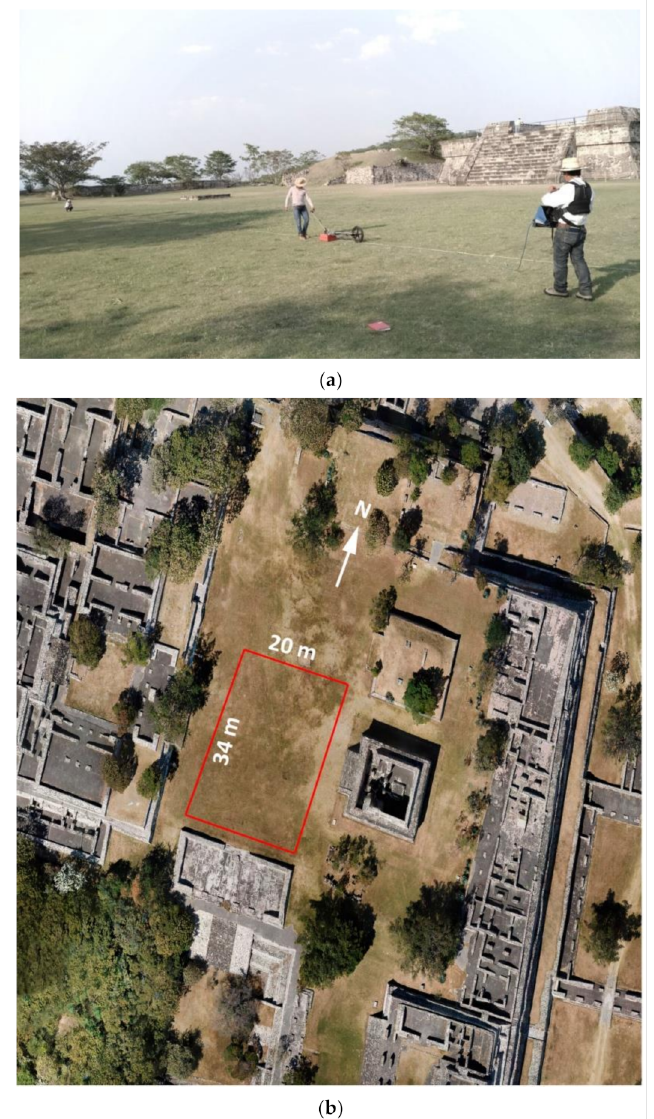
Figure 2. In front of Quetzalcoatl Temple, 81 profiles spaced 0.25 m apart were acquired with a 400 MHz antenna. The orientation of the profiles is S–N ( a ). Aerial view of the Xochicalco archaeological site showing the surveyed area in front of Quetzalcoatl Temple, where 81 profiles spaced 0.25 m apart were acquired with a 400 MHz antenna; the orientation of the profiles is S–N ( b